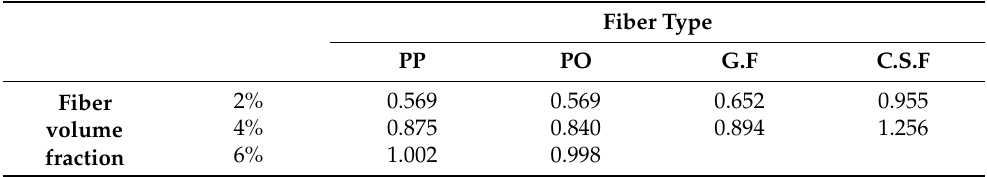
Table 7. Values of α factor from the experimental test results.